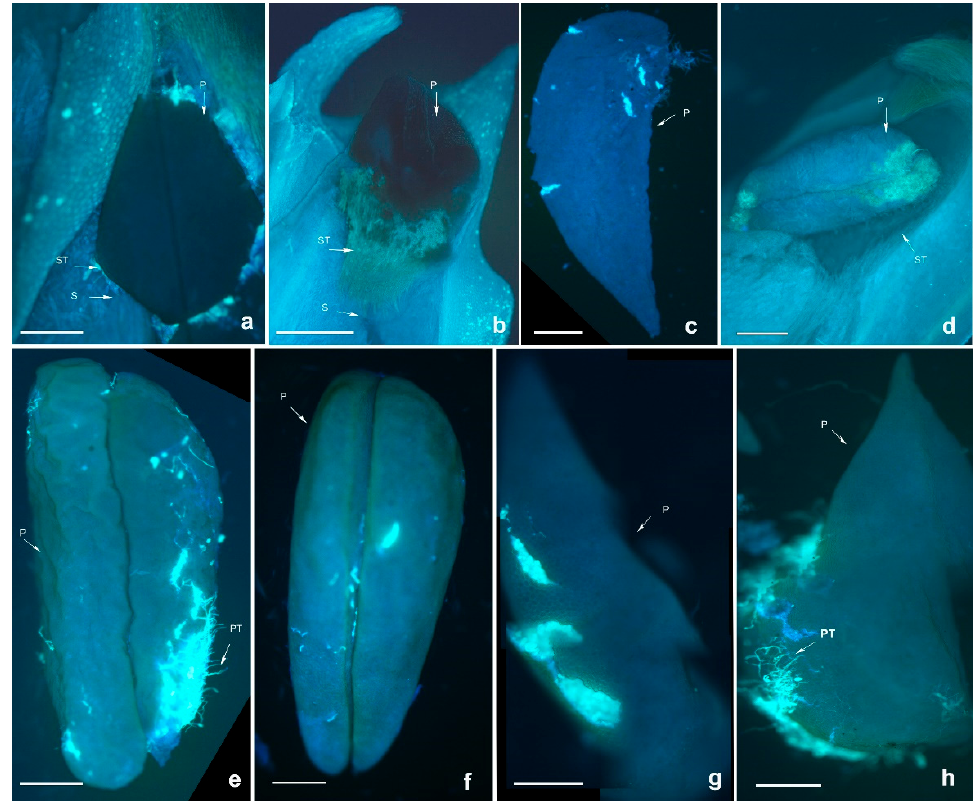
Figure 1. Growth of pollen tubes after self- and cross-pollination of Dendrobium longicornu in Shenzhen. PT: pollen tube; P: pollinium; S: style; ST: stigma. ( a ) 2 h after cross-pollination; ( b ) 24 h after cross-pollination; ( c ) 48 h after cross-pollination; ( d ) 96 h after cross-pollination; ( e ) 2 h after self-pollination; ( f ) 24 h after self-pollination; ( g ) 48 h after self-pollination; ( h ) 96 h after self-pollination. Bars = 300 µm.